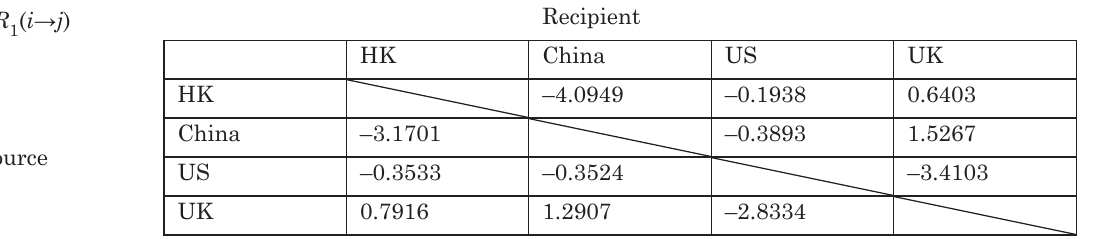
s . the 5% critical value is 1.645. , i t